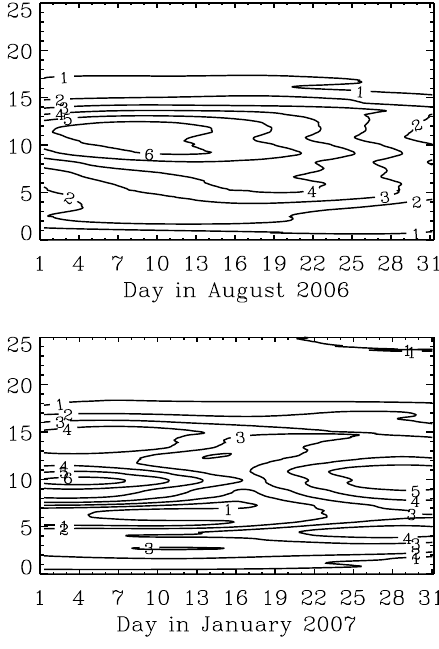
Fig. 12. Similar to Fig. 11, but for the QTDPW amplitudes.